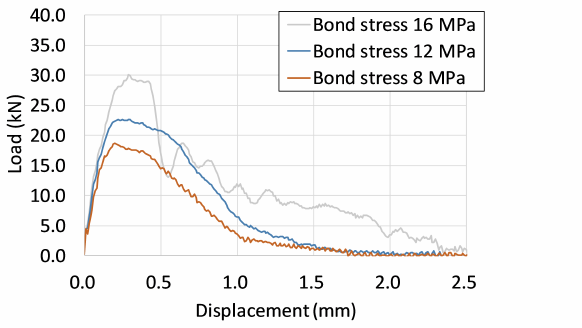
Figure 13. Load-displacement relationships with different bond stress.